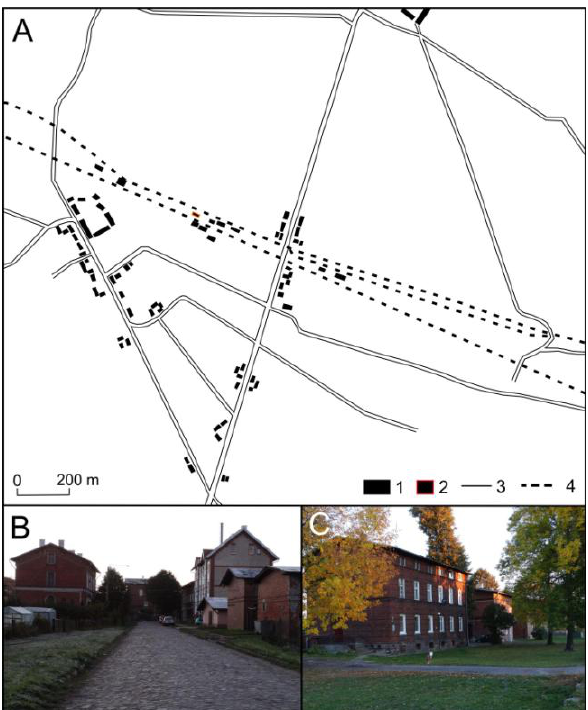
Fig. 5. Spatial layout of Korsze ( Korschen ) in the 19 th century (A), buildings for railway employees (B-C).